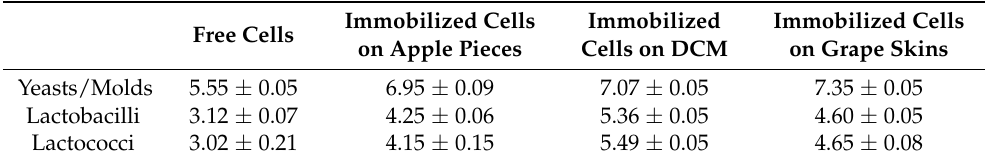
Table 1. Cell counts of kefir cells immobilized on natural supports after thermal drying. Free